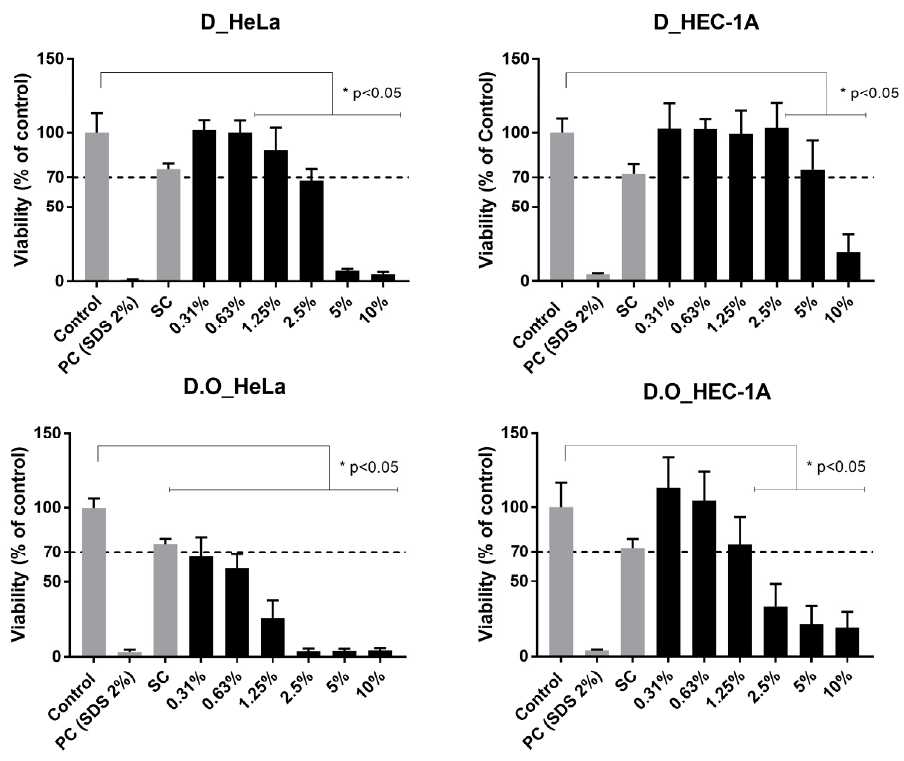
Figure 4. Cellular viability profile (MTT assay) of base formulation D tested in HeLa cell line and HEC-1A cell line and formulation D with oil tested in HeLa cell line and HEC-1A cell line. Cell viability is defined as percentage of the control treated only with culture media. Results are presented as the mean and standard deviations from 3 independent experiments. * represents statistically significant difference from negative control ( p < 0.05).